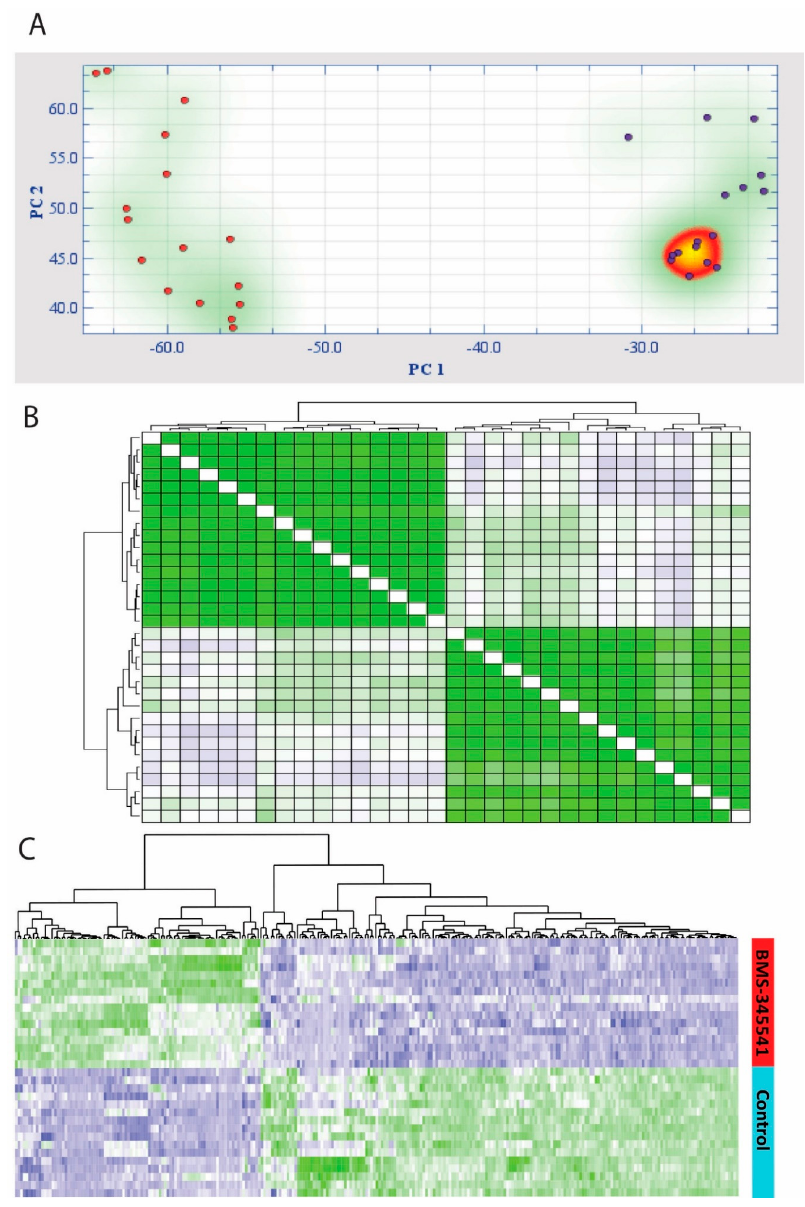
Figure 1. E ff ects of nuclear factor- κ B (NF- κ B) inhibition on the global gene expression profile of primary human acute myelogenous leukemia (AML) cells: We performed a feature subset selection (FSS) analysis and identified 277 genes that were di ff erently expressed (i.e., fold change at least ± 3, t-score at least ± 2.5) when comparing cultures treated with the NF- κ B inhibitor BMS-345541 and the corresponding control cultures. Most of these genes (183 / 277) were downregulated, and only 94 were upregulated in cells exposed to the NF- κ B inhibitor. ( A ) By performing a principal component analysis (PCA), we identified the first principal component to be highly discriminative for cells exposed to the NF- κ B inhibitor compared with control cells. ( B ) Discriminative hierarchical clustering with the distance matrix. The correlation visualization matrix displays the pairwise correlation between the 32 di ff erent cell cultures. Green and blue colors indicate high positive or negative correlation, respectively, between samples. ( C ) A hierarchical cluster analysis based on the 277 di ff erentially expressed genes was finally performed (Pearson’s correlation, complete linkage). Green color indicates upregulated genes, and blue color indicates downregulated genes in the BMS-345541 cultures compared with controls. The red bar to the right in the figure indicates intervention cultures, whereas purple indicates control cultures. The hierarchical cluster analysis clearly identified two patient / cell clusters that corresponded to the BMS-345541 containing and control cultures and two gene expression clusters that corresponded to up- and downregulated